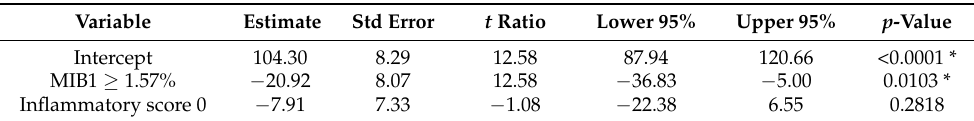
Table 2. Multivariate linear regression of percentual volumetric tumor growth.